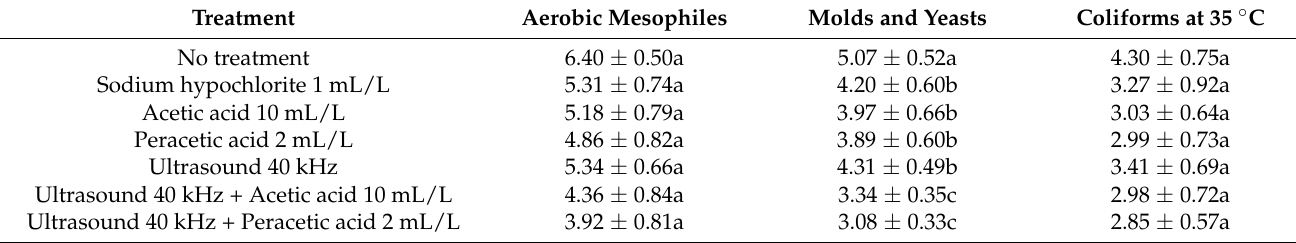
Table 4. Mean aerobic mesophiles, molds and yeasts and coliform at 35 ◦ C counts (log CFU/g) in strawberries not treated and submitted to different sanitization procedures and stored for 9 days at 6 ± 1 ◦ C.